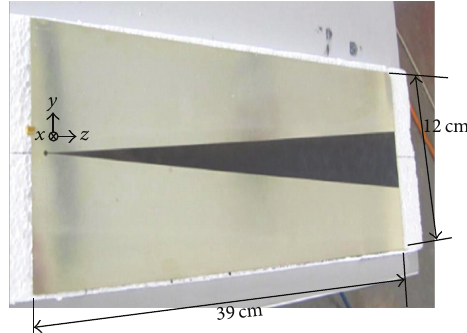
Figure 3: UWB Linear Tapered Slot Antenna.